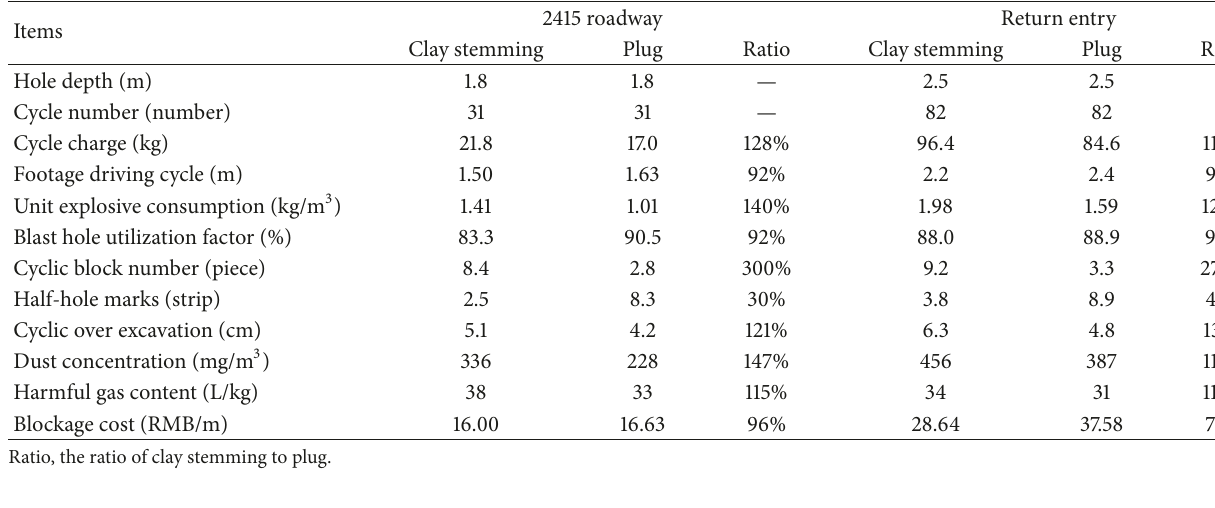
Table 7: Main test parameters between traditional clay stemming and new plug.